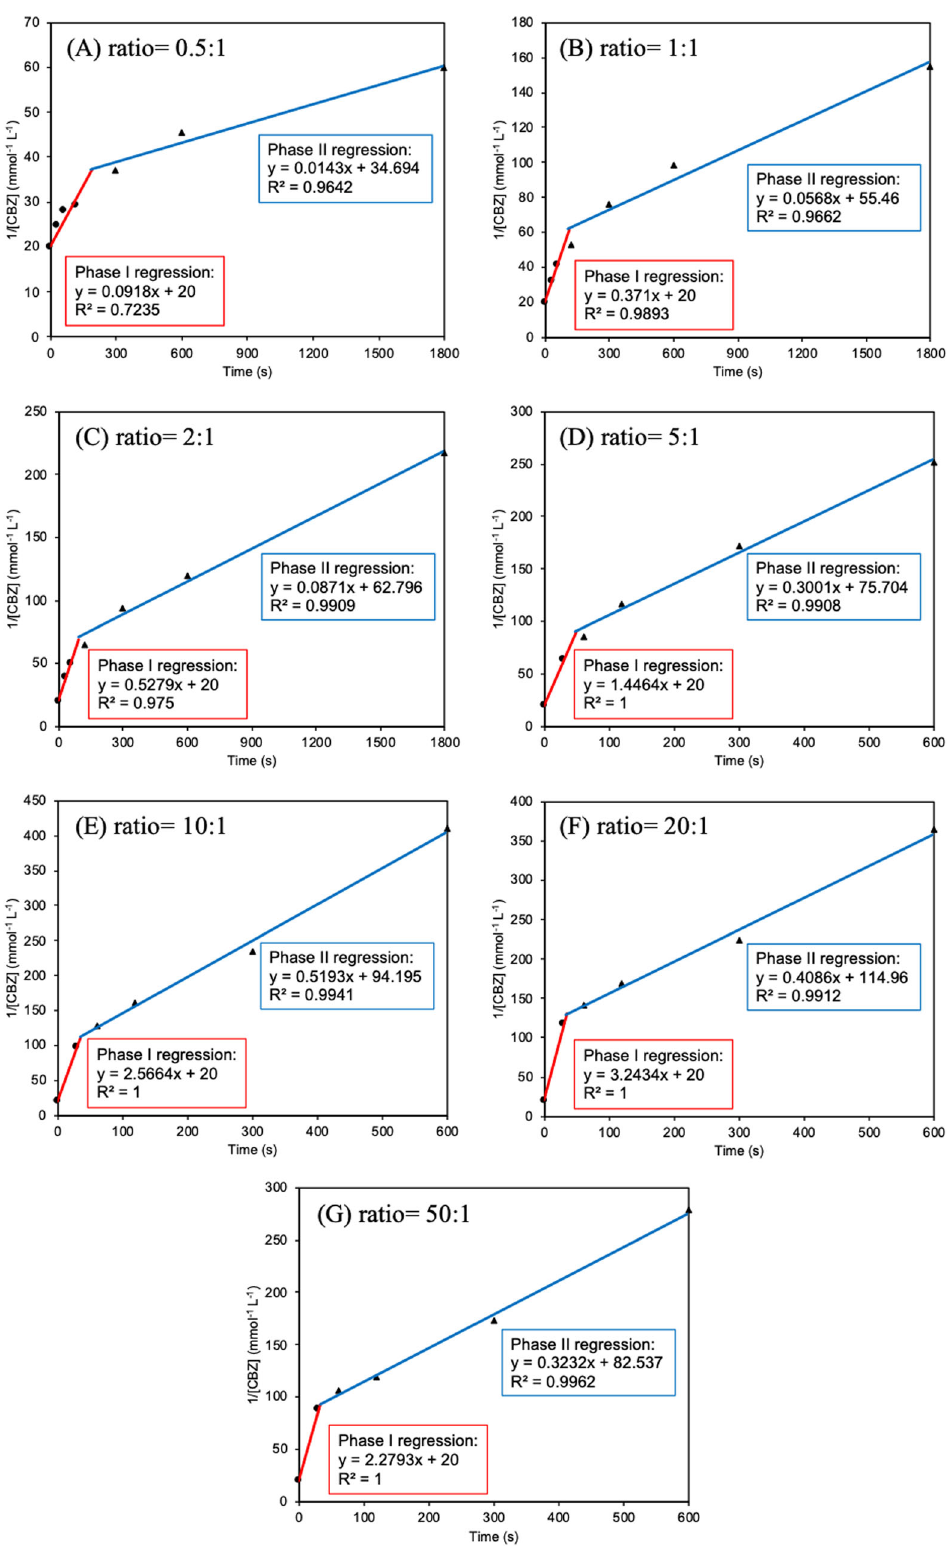
Fig. 2 The regressions of CBZ degradation by the Fenton process using a two-stage model. The [Fe 2 + ] is fi xed at 50 μ M with various [H 2 O 2 ]:[Fe 2 + ] ratios in ( A – G